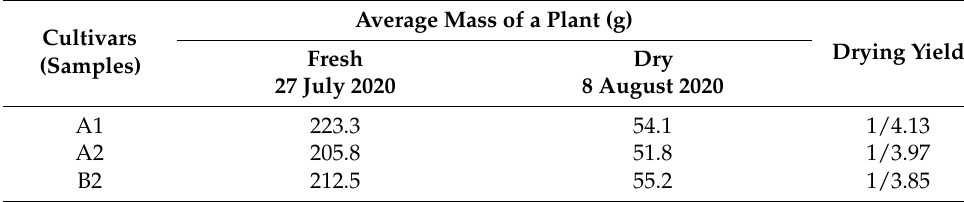
Average Mass of a Plant (g)